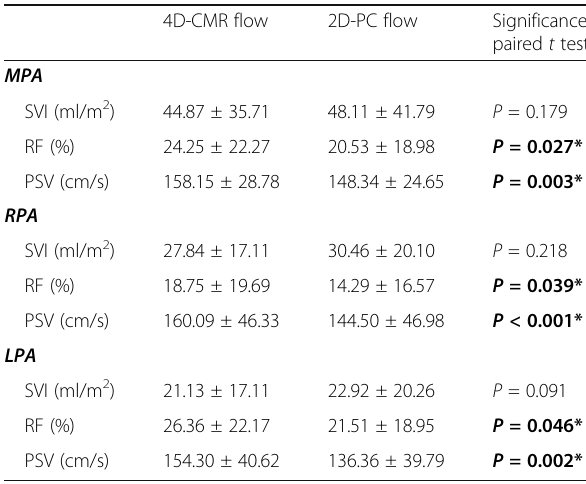
Table 1 Comparison between the 4D-CMR and 2D-PC flows across the pulmonary arteries regarding the stroke volume index, regurgitation fraction, and peak systolic